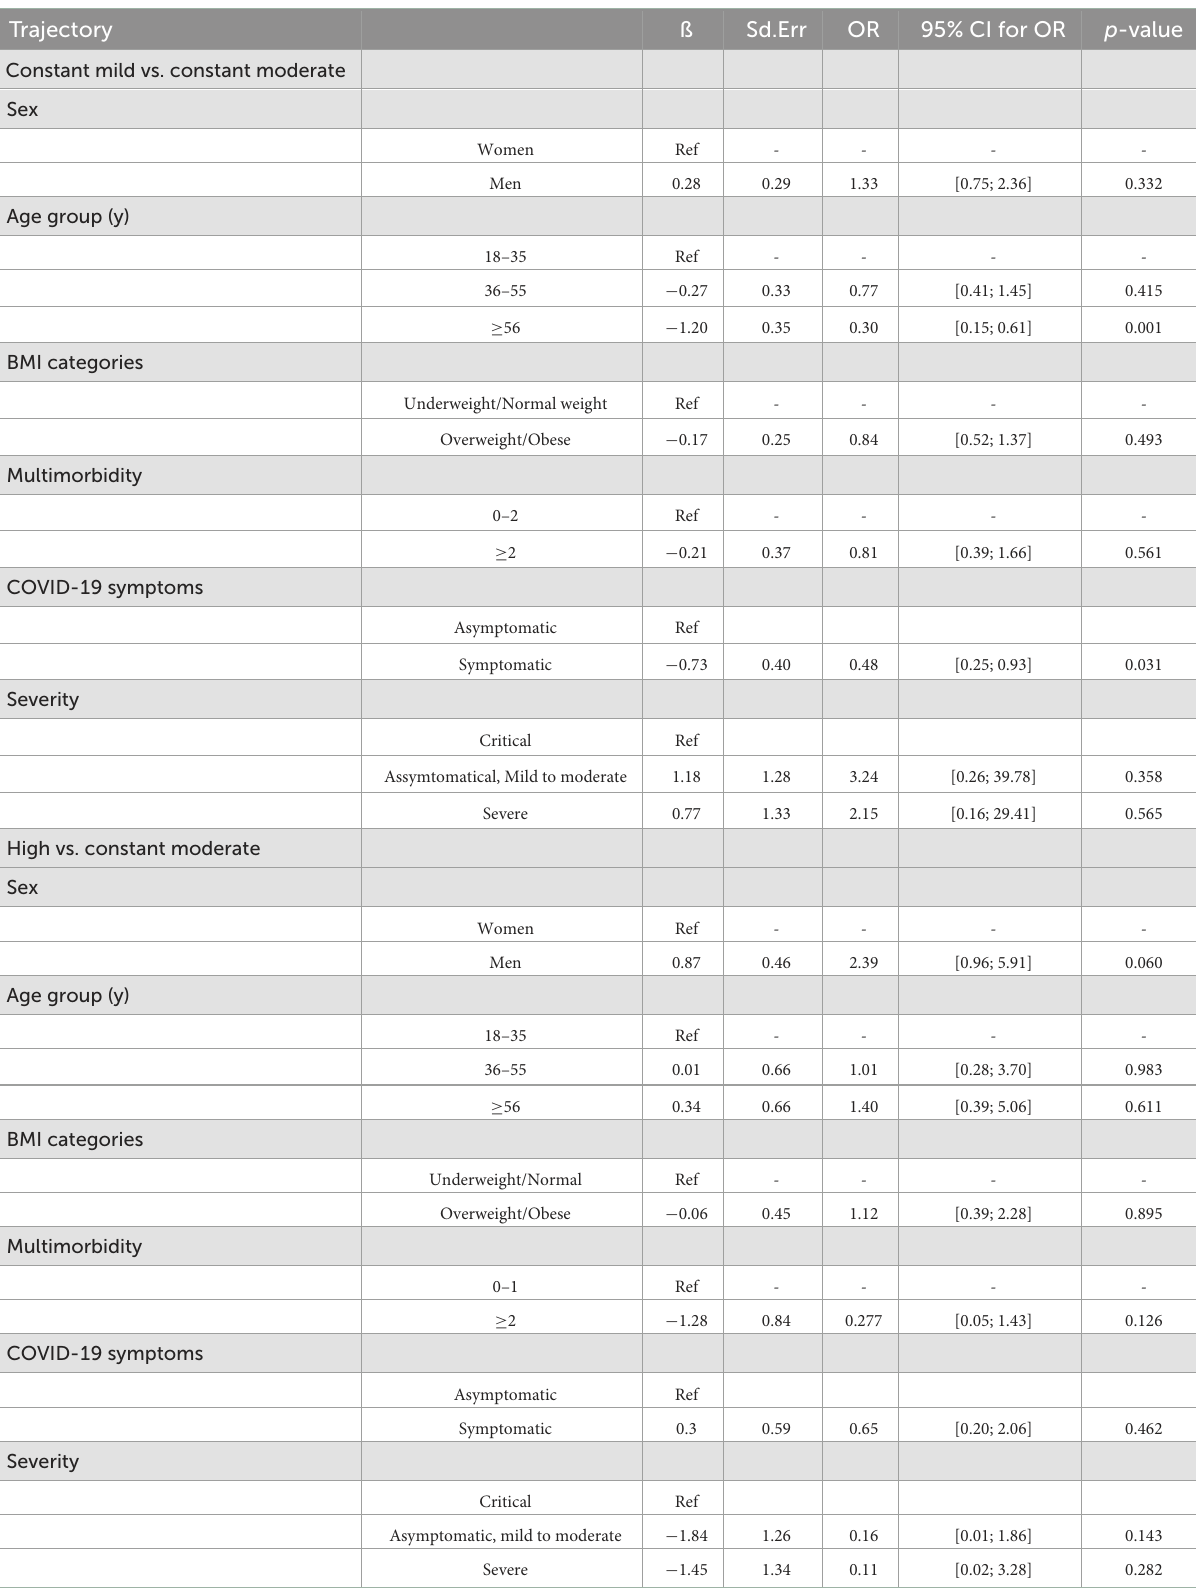
TABLE 6 Sociodemographic and health related factors associated with antibody concentrations. Trajectory ß Sd.Err Constant mild vs. constant